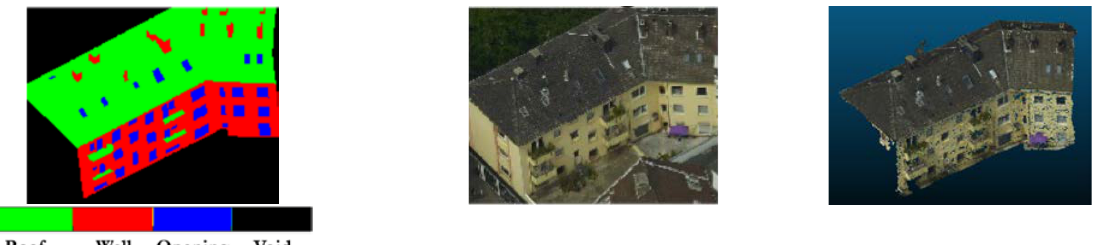
Figure 3 Example of our dataset. Left: annotated façade, Middle: façade image, and Right: cropped façade point